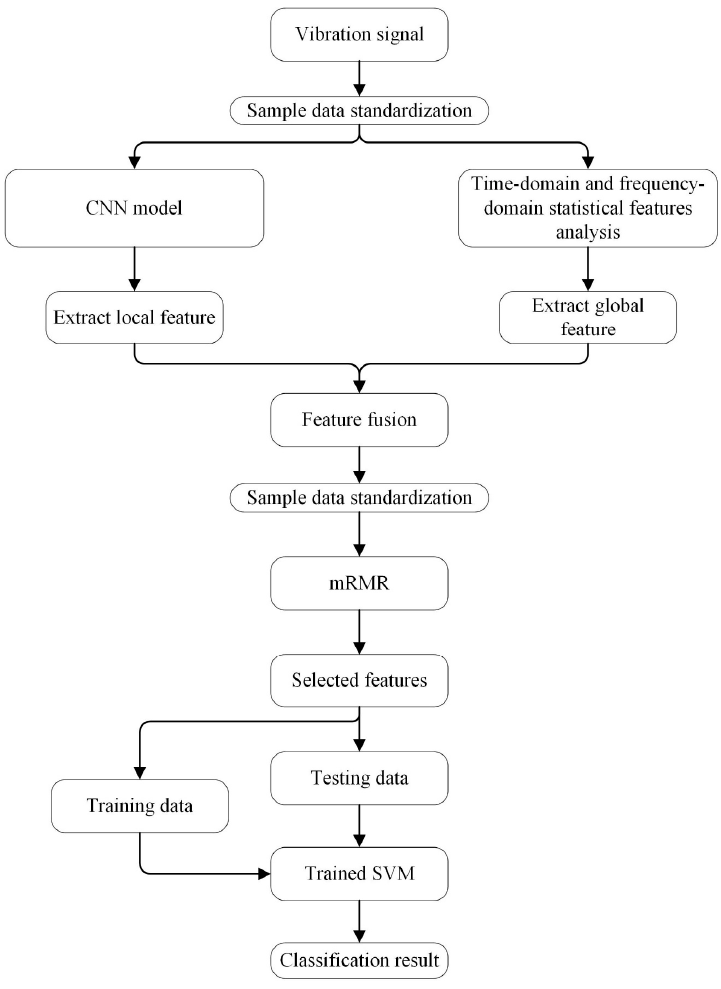
Figure 5. The intelligent fault diagnosis process of GL-mRMR-SVM model.